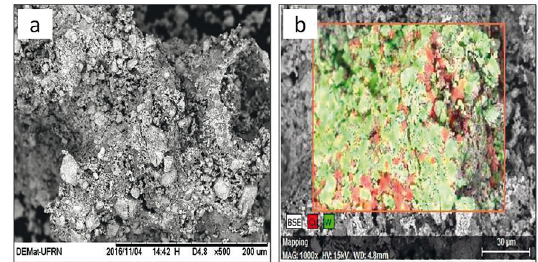
Figure 6. (A) SEM micrograph of W-30 wt% Cu composite powder and (b) EDS mapping